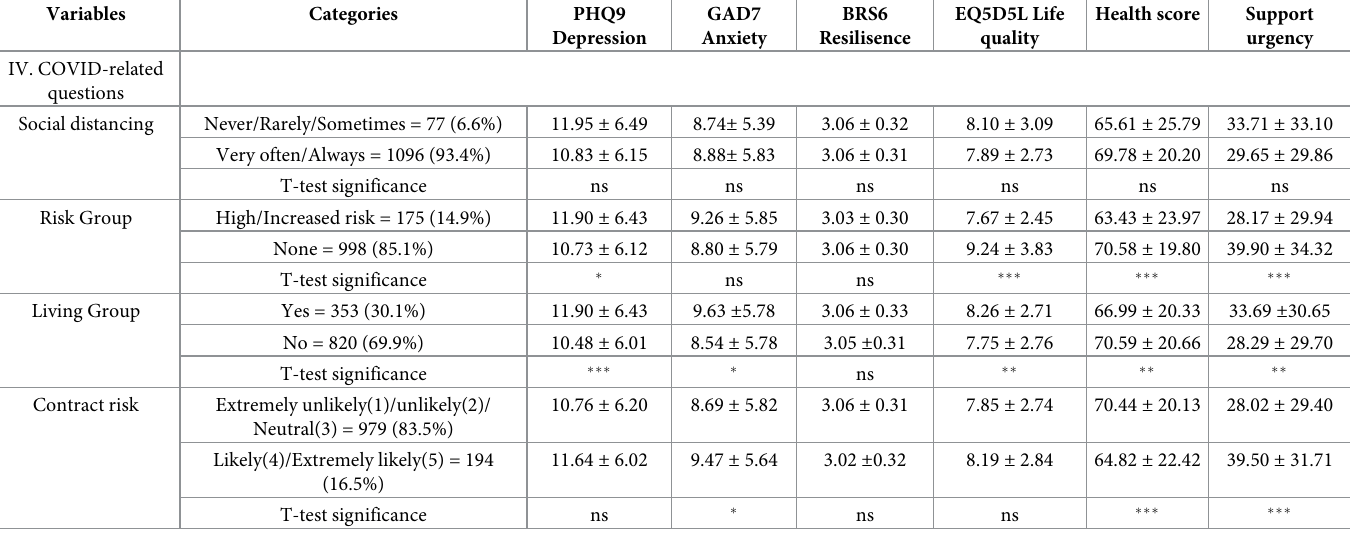
Table 5 shows the descriptive analysis on decision variables. The mean value of PHQ9 (depression) was in the moderate range and the mean GAD7 score (anxiety) was in the mild range; the BRS6 measure of resilience was very slightly above the lower boundary of the range [3.00 to 4.30], just within the average level of normal resilience. The EQ-5D-5L mean of 7.9 is relatively close to the best possible value of 5, suggesting good quality of life for the sample as a whole. The mean self-rated health score, which is part of the EQ-5D-5L instrument, was 69.51, but with a large standard deviation suggesting a wide variation across the sample. The per- ceived support needs value of 29.9 suggests relatively low levels of urgent support was required during lockdown across the sample. Table 10 shows distribution of PHQ9, GAD7 and BRS6 scores across the severity levels and table VII shows the numbers and percentages of students who scored above and below the clinical cut-offs on the PHQ9 and GAD7, as a whole sample and by gender. Table 11 shows Table 9. Bivariate analysis on COVID-related questions.